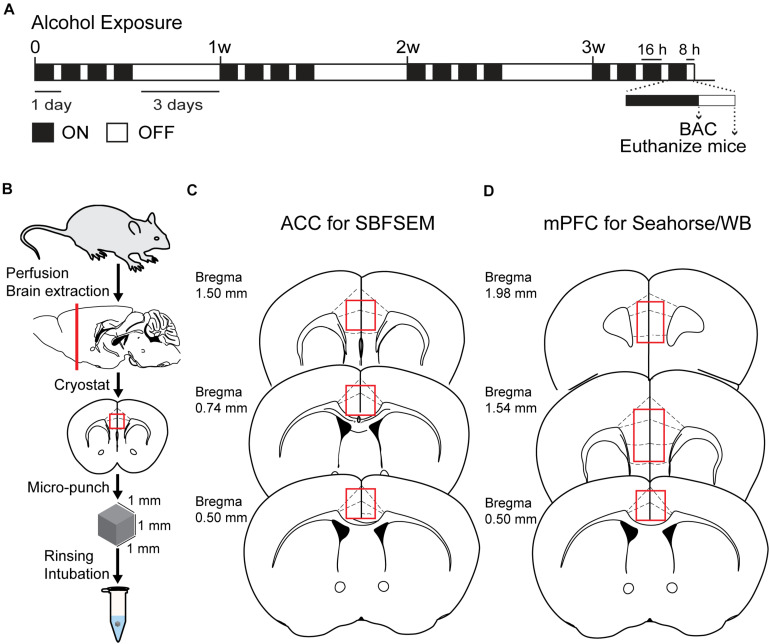
Chronic intermittent exposure to alcohol procedure and BAC. (A) Illustration of chronic intermittent alcohol exposure. (B) Process of tissue extraction for SBESEM study. (C) The red square displays ACC used in the SBFSEM study. (D) The red rectangle displays mPFC used in the Seahorse and WB studies.